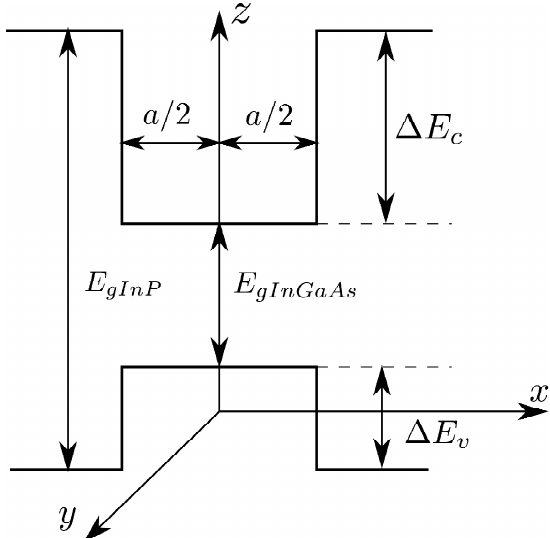
Fig. 2 . A schematic representation of a single QW of InGaAsP/InP